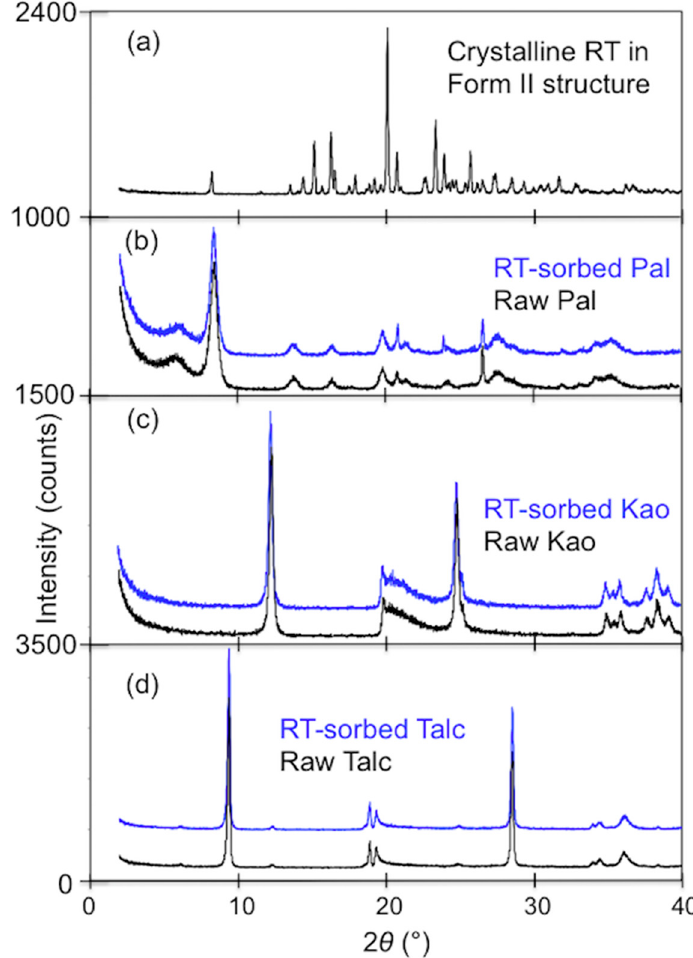
Figure 2. X-ray di ff raction patterns of ( a ) crystalline RT, ( b ) Pal, ( c ) Kao, and ( d ) talc before and after RT sorption.